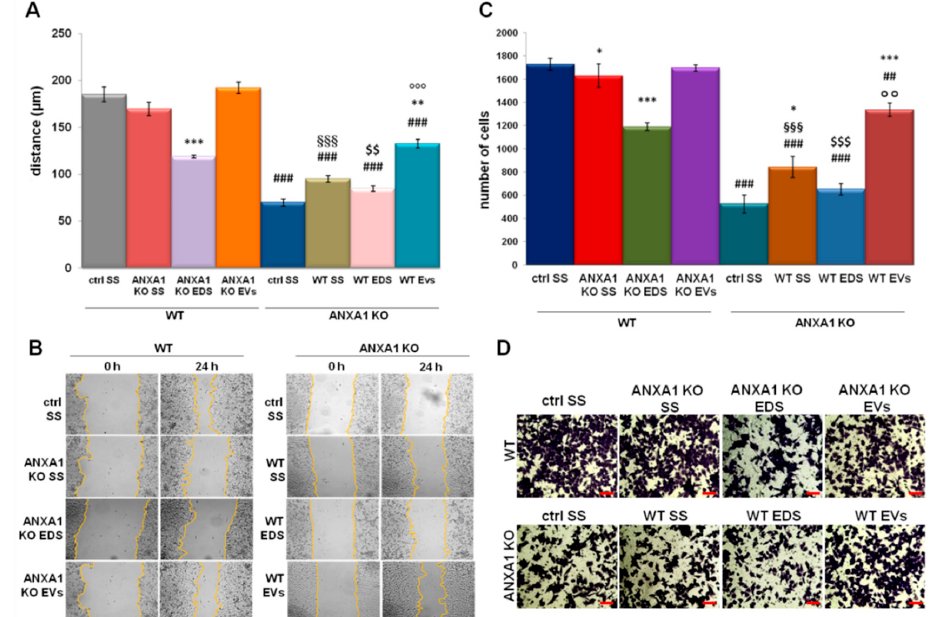
Figure 2. EVs released by WT and ANXA1 KO MIA PaCa-2 affected cell migration and invasion rate. Effects of starved supernatants (SS), EDS, and EVs fractions from MIA PaCa-2 and ANXA1 KO MIA PaCa-2 on WT and ANXA1 KO recipient cells and viceversa in Wound-Healing ( A ) and invasion ( C ) assays. Representative images for migration and invasion assays are reported in ( B ) and ( D ), respectively. Bar = 50µm. Statistical significance was calculated using t -test, * (asterisk) p < 0.05, ** p < 0.01, *** p < 0.001 treated cells vs untreated controls; ## p < 0.01 and ### p < 0.001 for each point of ANXA1 KO MIA PaCa-2 cells vs WT one, §§§ p < 0.001 for the experimental points treated with ANXA1 KO cell SS vs WT MIA PaCa-2 one, $$ p < 0.01, $$$ p < 0.001 for cells treated with ANXA1 KO MIA PaCa-2 EDS vs WT MIA PaCa-2 EDS and ◦◦ (circlets) p < 0.01 and ◦◦◦ p < 0.001 for cells in presence of EVs secreted by ANXA1 KO MIA PaCa-2 vs EVs from WT MIA